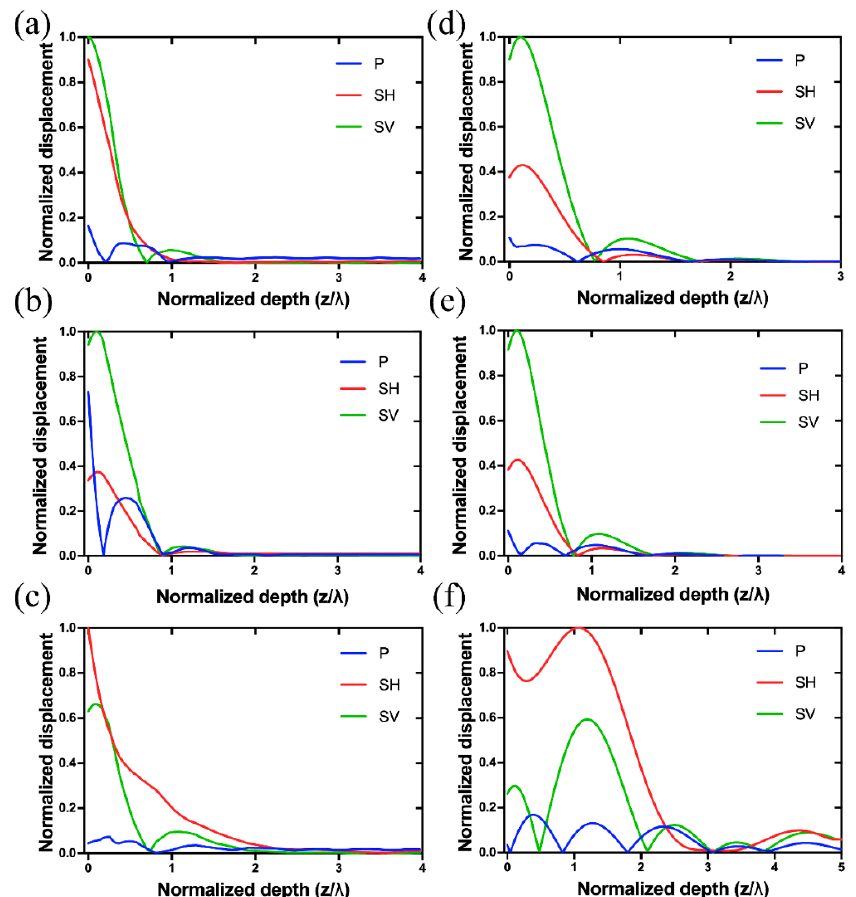
Figure 5. Calculated relative displacements of P, SH, and SV waves of Peak 1 ( a ), Peak 2 ( b ) and Peak 3 ( c ) when λ = 6.32 µ m; Calculated relative displacements of P, SH, and SV waves of Peak 1 ( d ), Peak 2 ( e ) and Peak 3 ( f ) when λ = 20 µ m .